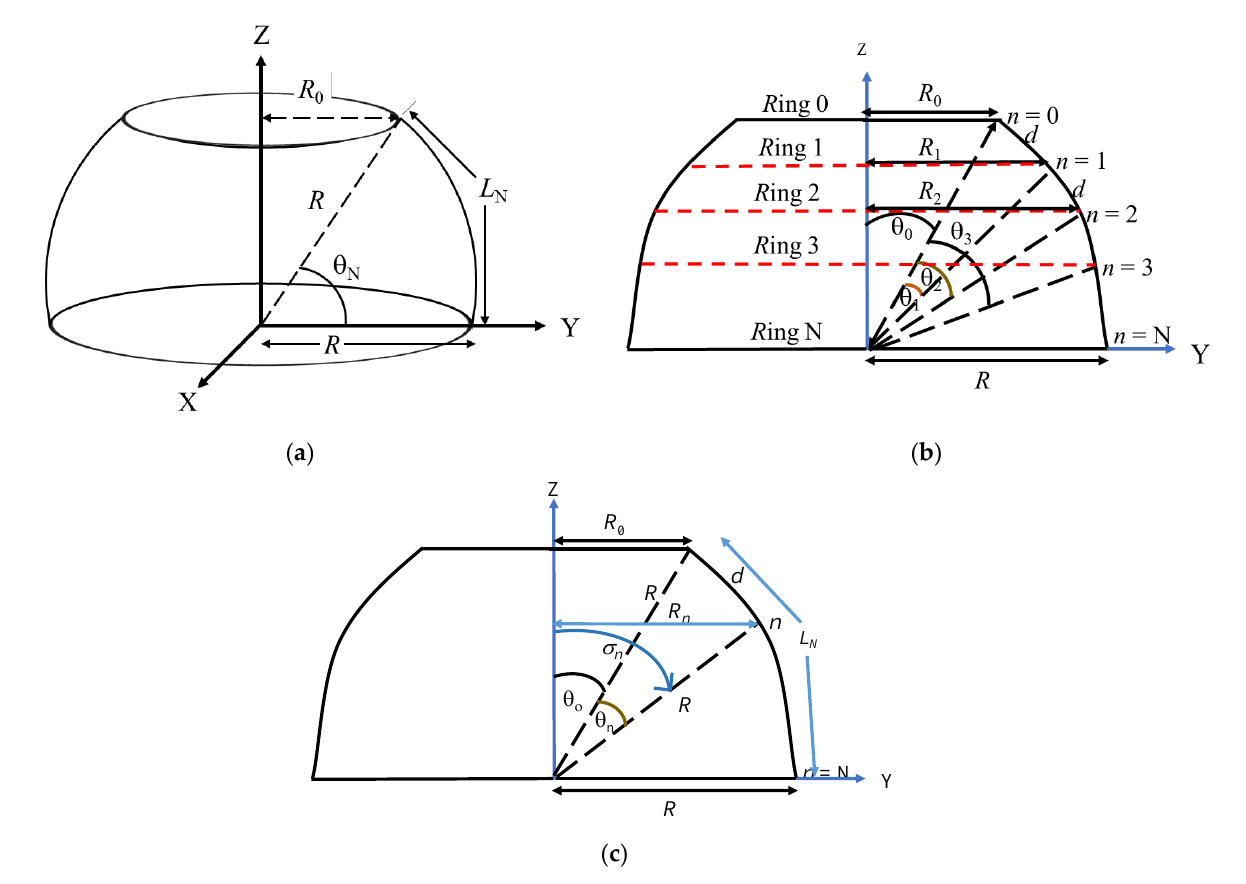
Figure 1. Schematic of the array hosting platform: ( a ) basic; ( b ) simplified analytical; and ( c ) gener- alized analytical views.